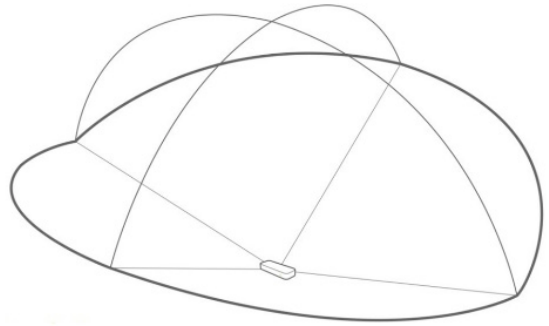
Figure 3. The approximate shape of the LMC workspace.